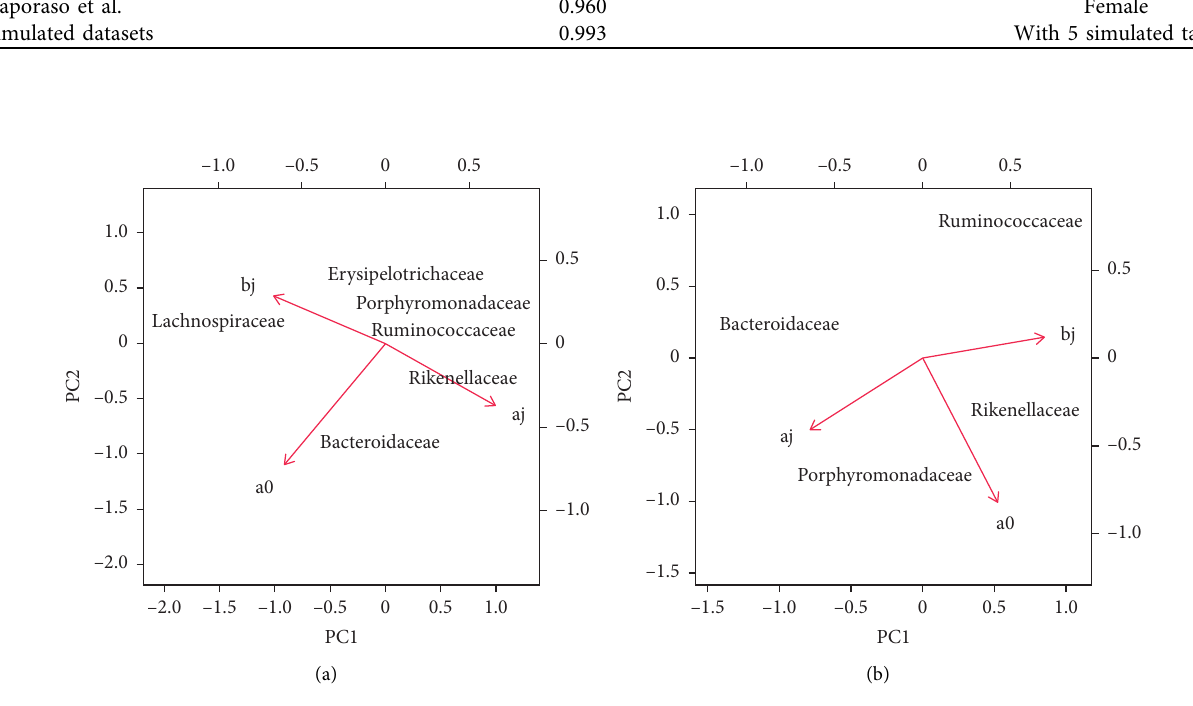
Figure 6: PCA Biplot for IBS patient (a) and healthy male (b). Table 4: MTA output related to the contribution of each taxon to the longitudinal microbial profiling in IBS scenario. Note that a higher absolute value indicates a stronger contribution to the common